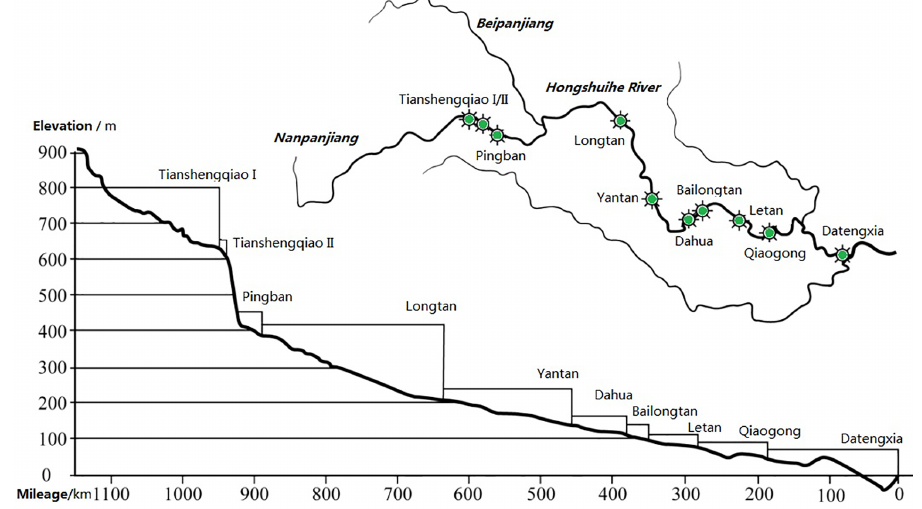
Figure 1. Sketch map of cascade hydropower stations in Hongshuihe basin.